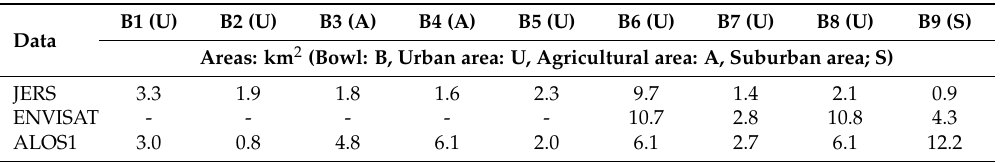
Table 1. Area of subsidence bowls in Figure